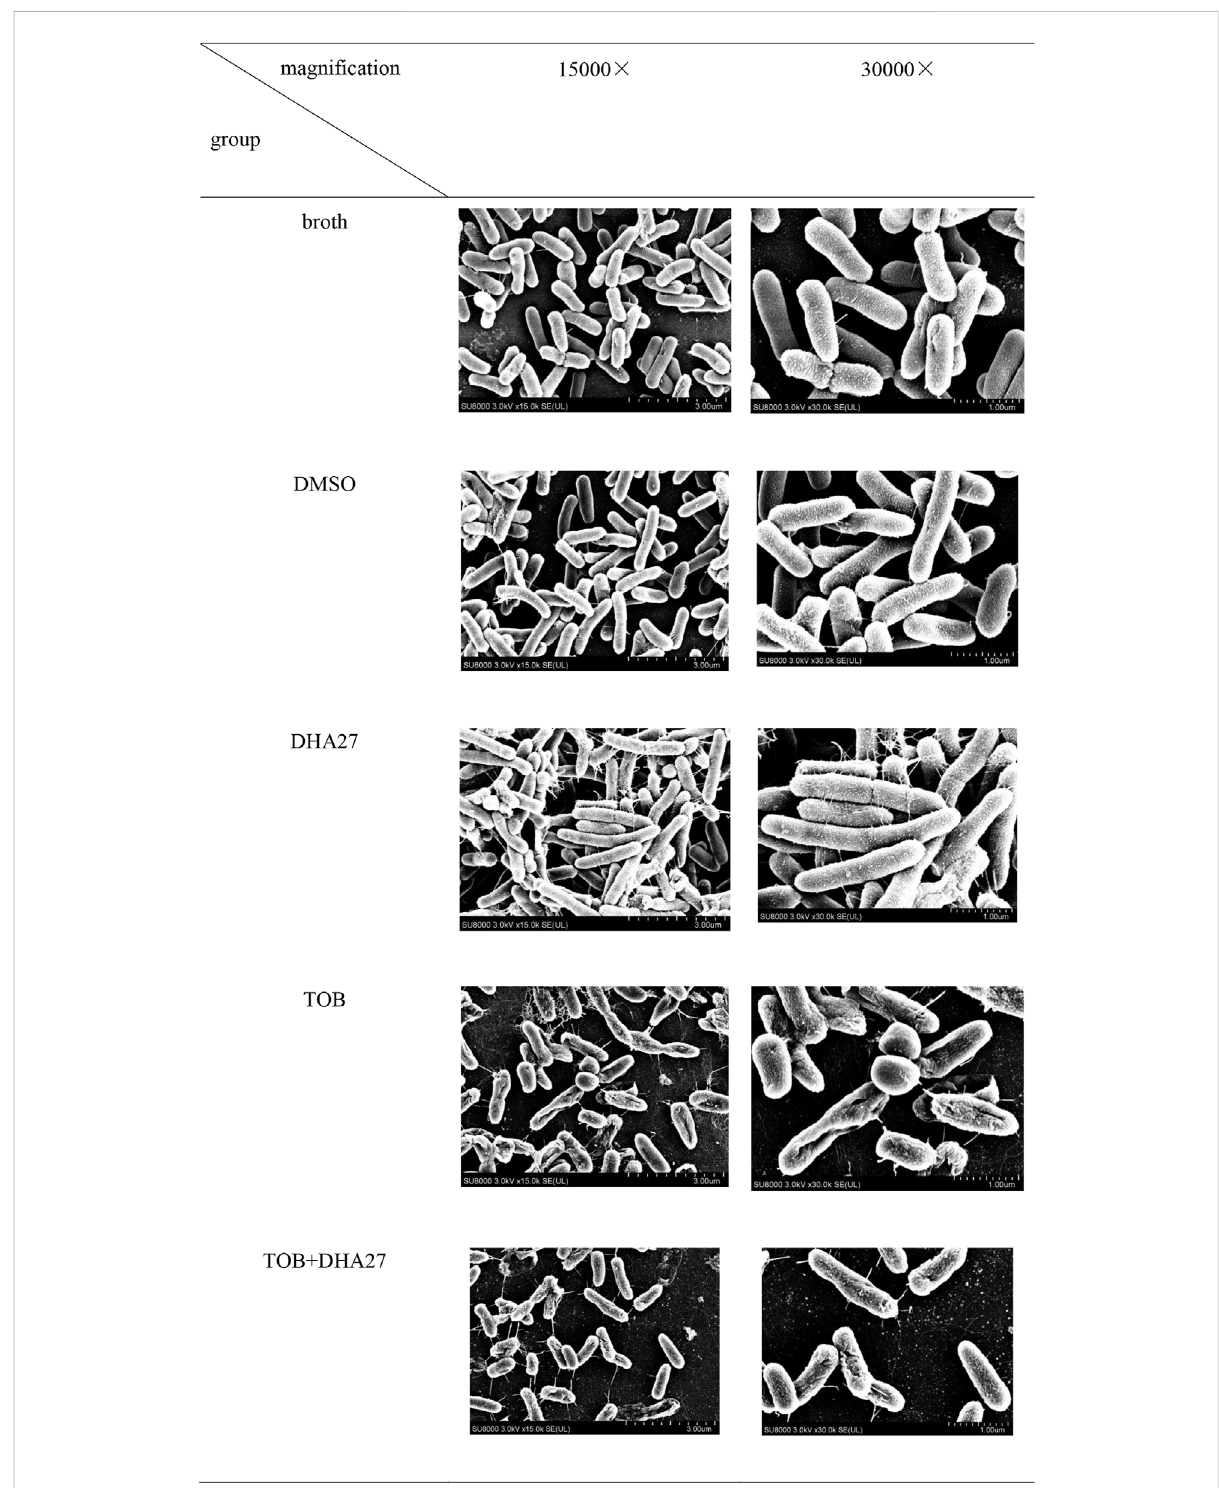
FIGURE 4 Effects of DHA27 in combination with tobramycin (TOB) on the morphological structure of PA16 as observed using scanning electron microscopy.